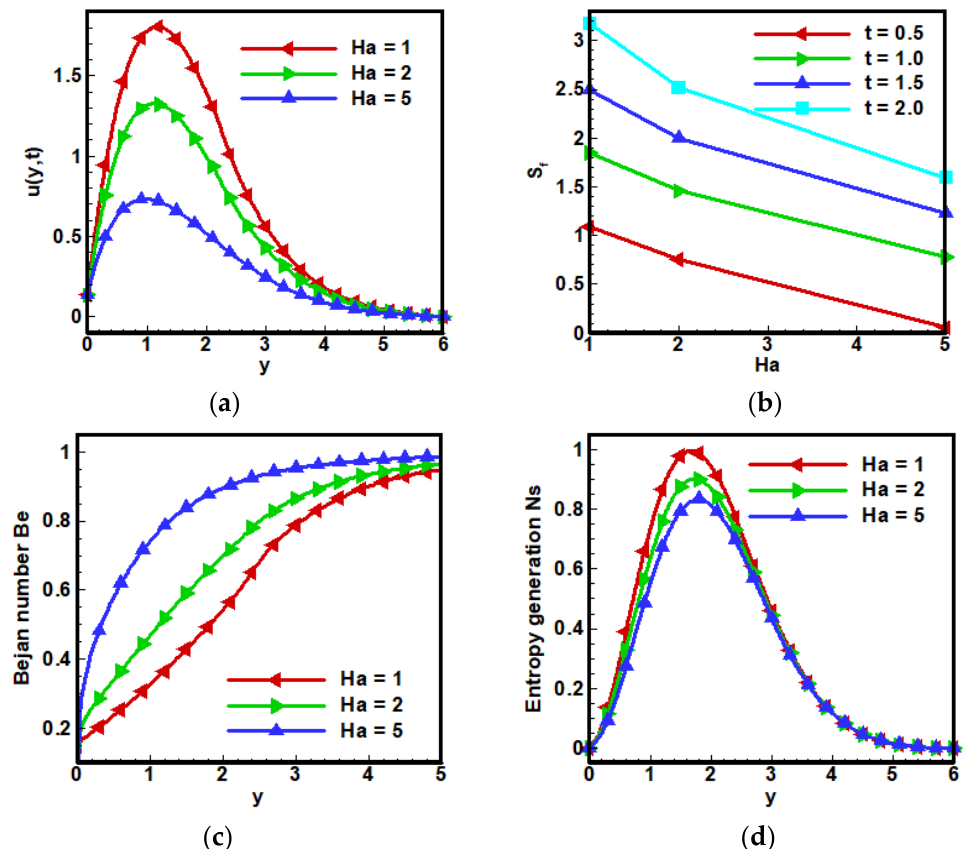
Figure 3. Impact of the Hartmann number on ( a ) dimensionless velocity profile, ( b ) coefficient of skin friction, ( c ) Bejan number and ( d ) entropy generation when Λ 1 = 0.6, Λ 2 = 0.5, Gr = 5,Ha = 10, Pr = 6, 𝑄 = 5, 𝑁𝑟 = 3.5, 𝑎 = −1, 𝐵𝑟 = 0.5, Ω = 10, 𝜙 = 0.1 .